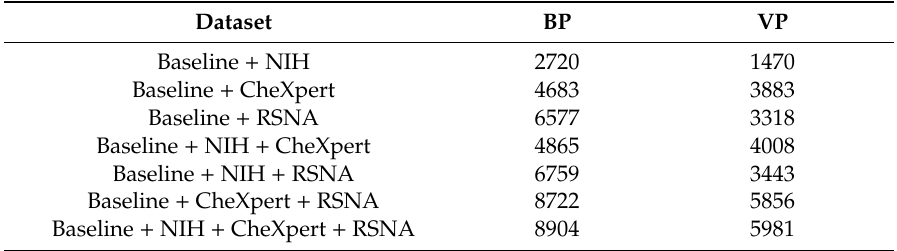
Table 7. Number of samples in weakly labeled augmented training data.